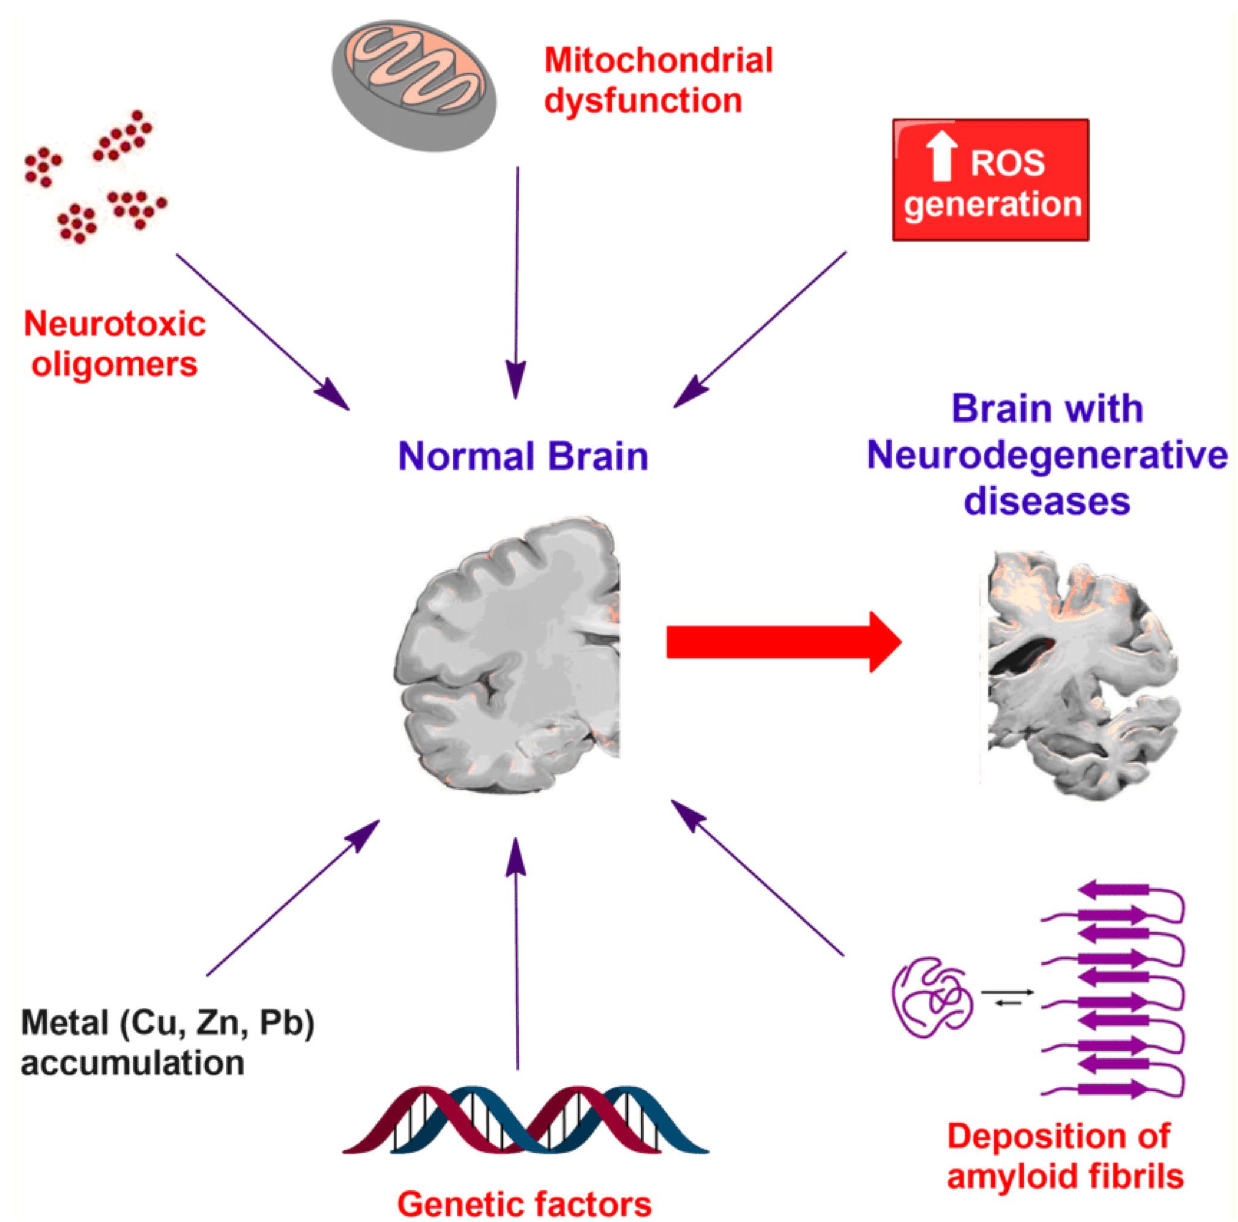
and Gabr [283]. Reproduced under the Creative Commons Attribu- tion-NonCommercial-ShareAlike 4.0